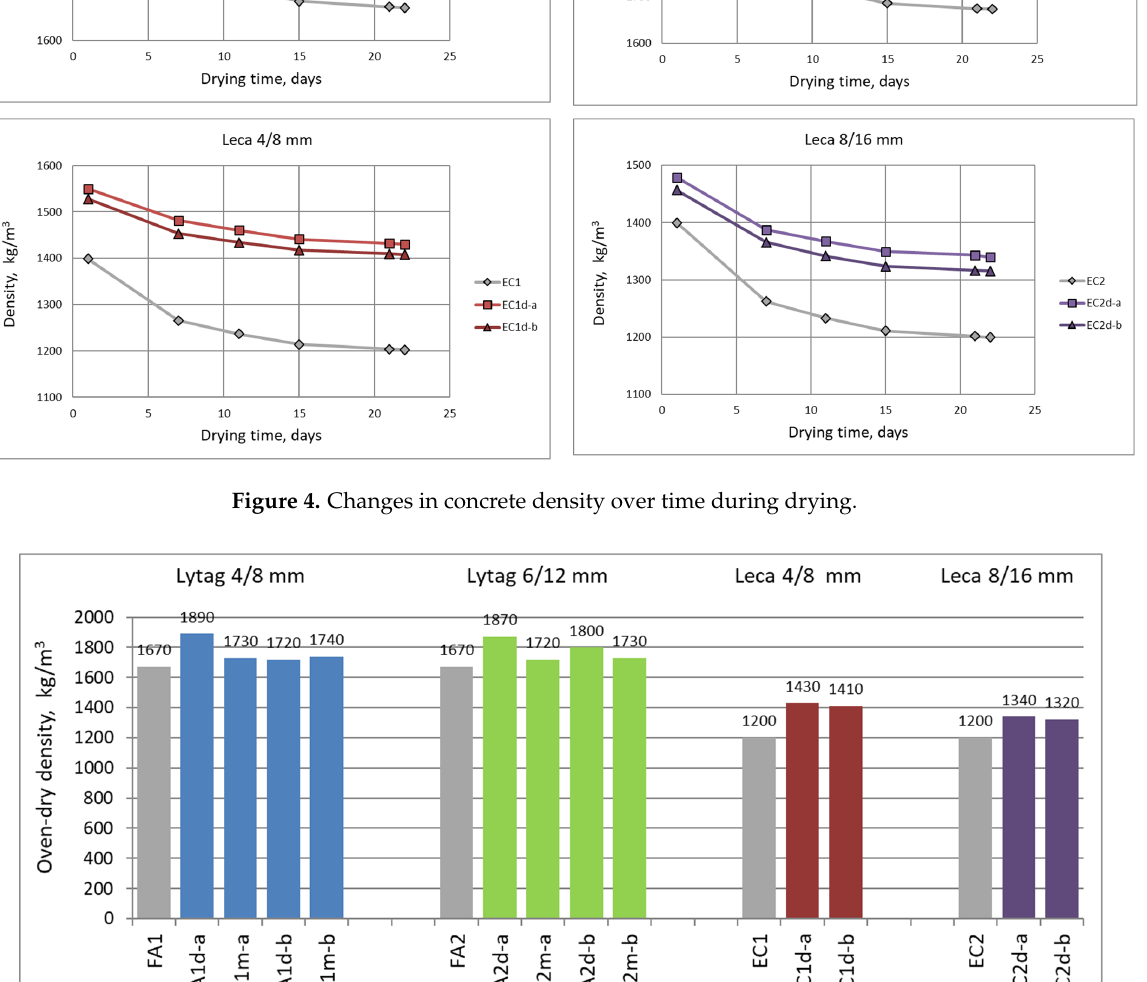
Figure 5. Mean oven-dry density of concretes with plain and impregnated lightweight aggregates.